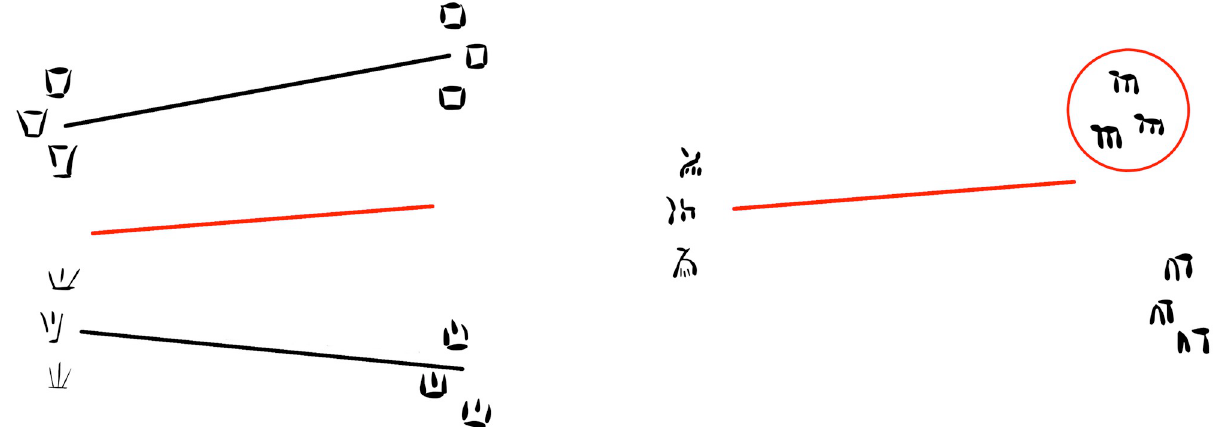
Fig 9. On the left: The paleographic vector (red) was first calculated from the difference vector (black) between centroids of signs from clay tablets and centroids of signs from other documents. On the right: the vector was applied to find a missing correspondence between signs shapes from the same two